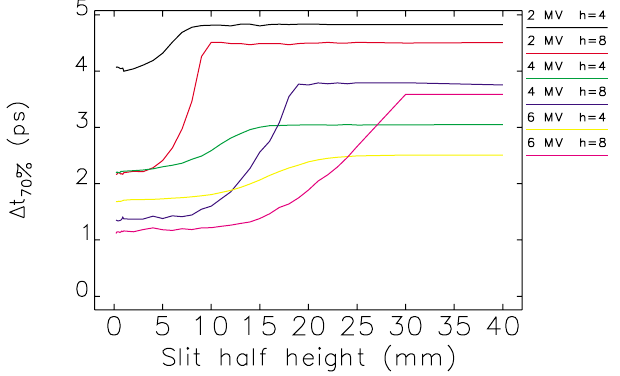
FIG. 25. Emittance as a function of achievable pulse length for constant 50% transmission through the slits.